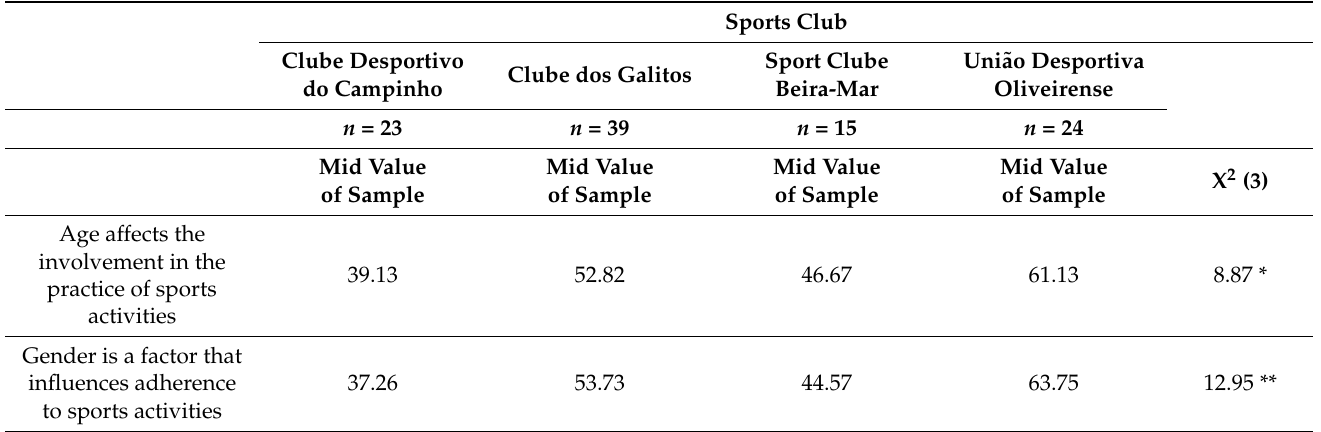
Table 4. Differences and associations at the club level: sports practice.